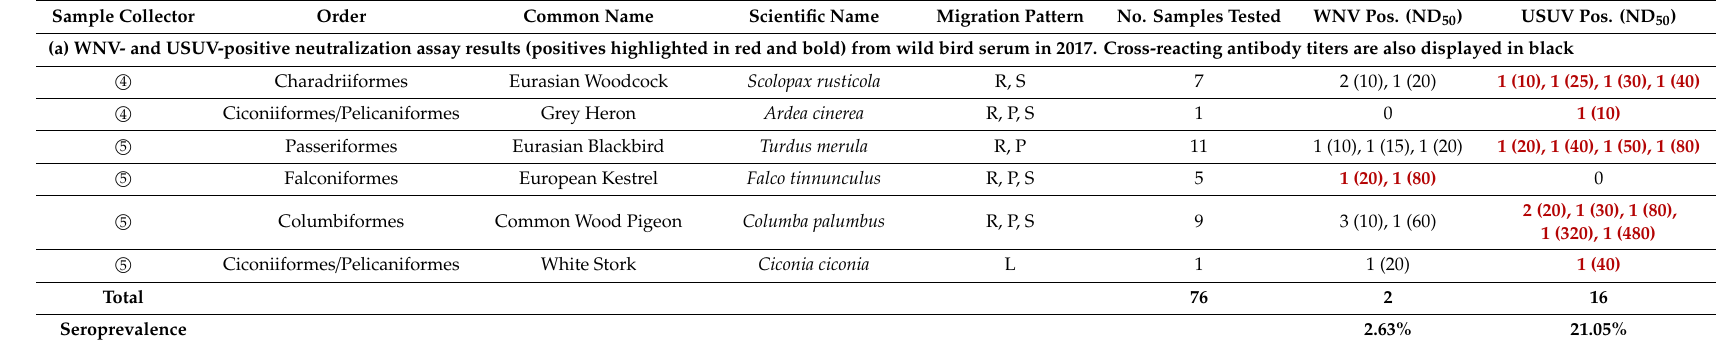
Table 5. WNV- and USUV-positive neutralization assay results from wild bird serum samples Region B—Eastern Germany. Sample